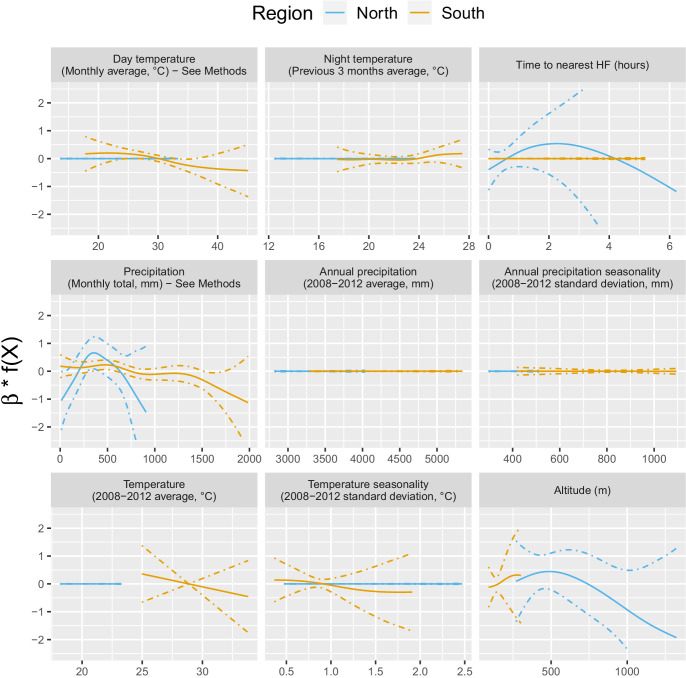
Relationships between malaria incidence and the environmental covariates in the multivariable model described in equation 2 (30 km radius and 1-year temporal lag), additionally adjusted for the probability of seeking treatment, the spatio-temporal structure of the data (f⁢(t), f⁢(L⁢a⁢t,L⁢o⁢n⁢g) and village random intercepts) and malaria incidence in the previous 1 and 2 months.Dashed lines are for 95% confidence intervals. Note that the y scale has been trimmed a bit for better visualization.